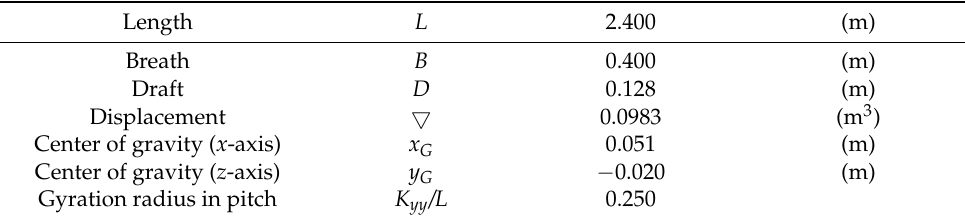
Table 1. Principal dimensions of model.